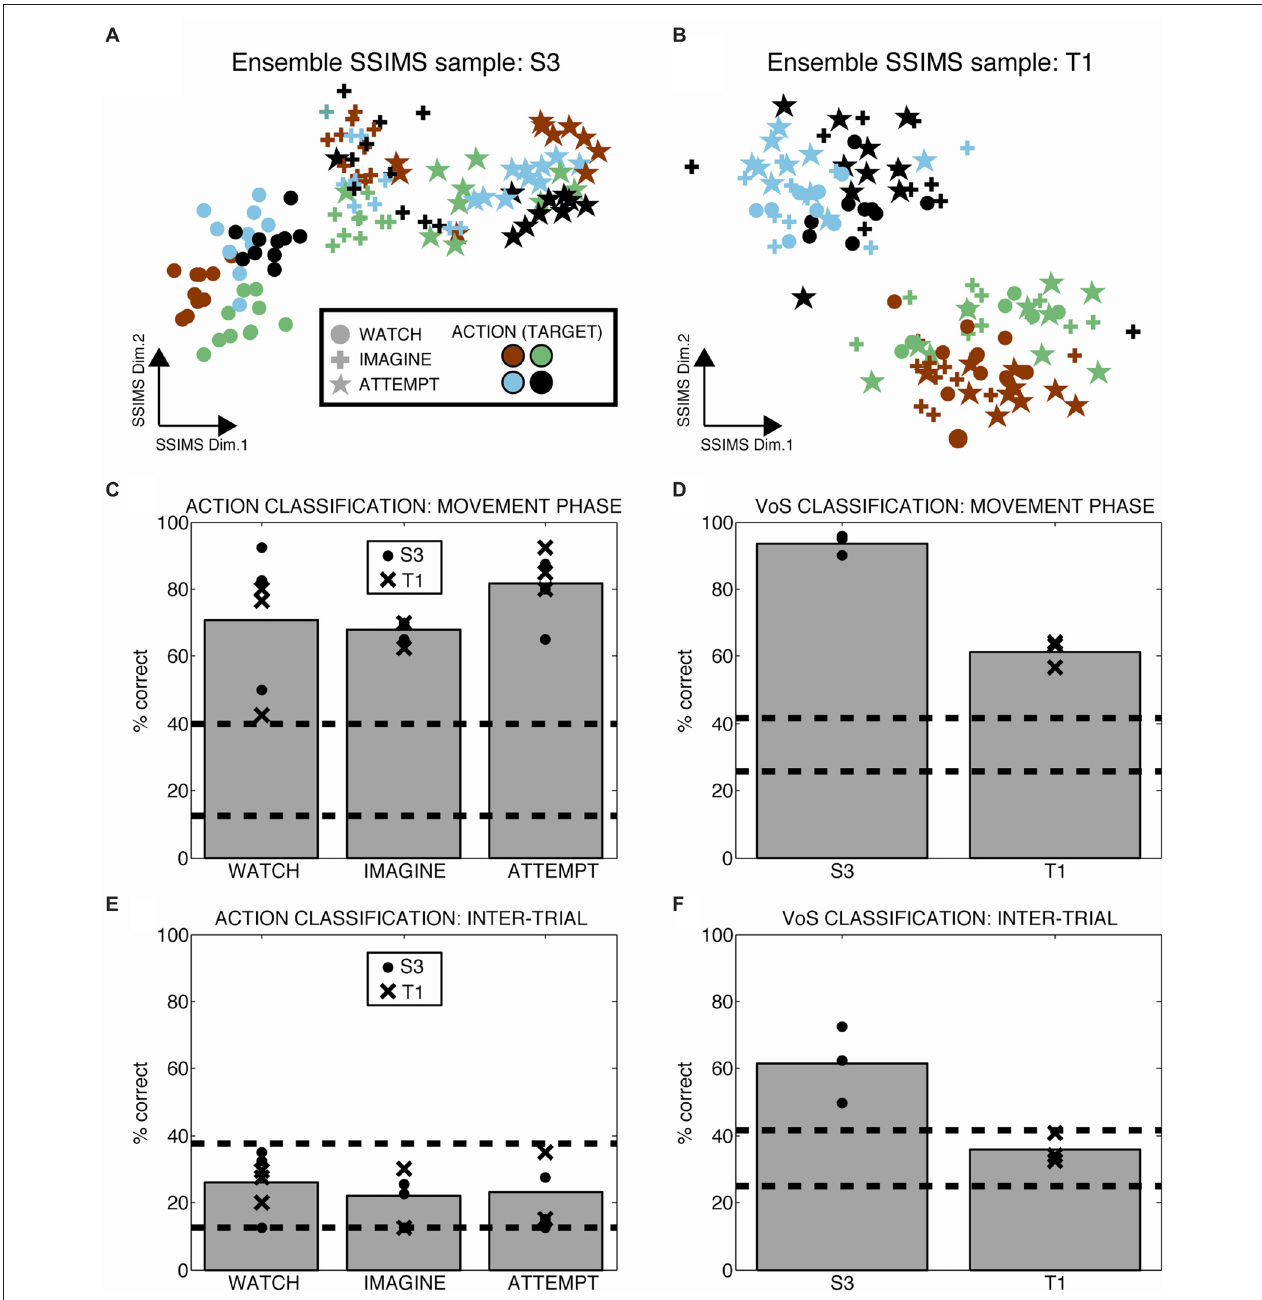
FIGURE 4 | Ensemble firing patterns reflect action as well as volitional states. (A,B) 2D SSIMS plots for one sample session in each participant. Each point represents the activity of the entire simultaneously recorded ensemble during one trial. The distance between points represents the similarity between the ensemble-level spiking patterns observed. Symbols denote W, I, A condition and colors denote reach target position, as shown in the key. Clustering of similar symbols denotes similarity between trials in the same VoS condition, while clustering of similar colors denotes similarity between trials with the action (movie). (C,D) Action and VoS decoding results for each session. Dashed lines represent the 95% confidence interval of the chance distribution (obtained empirically from 10,000 random shuffles of trial labels). (E,F) Similar plots to (C,D) , except using 0.5 s of data recorded before the presentation of each movie (inter-trial interval, ITI). Only VoS decoding in participant S3 was above chance levels during the